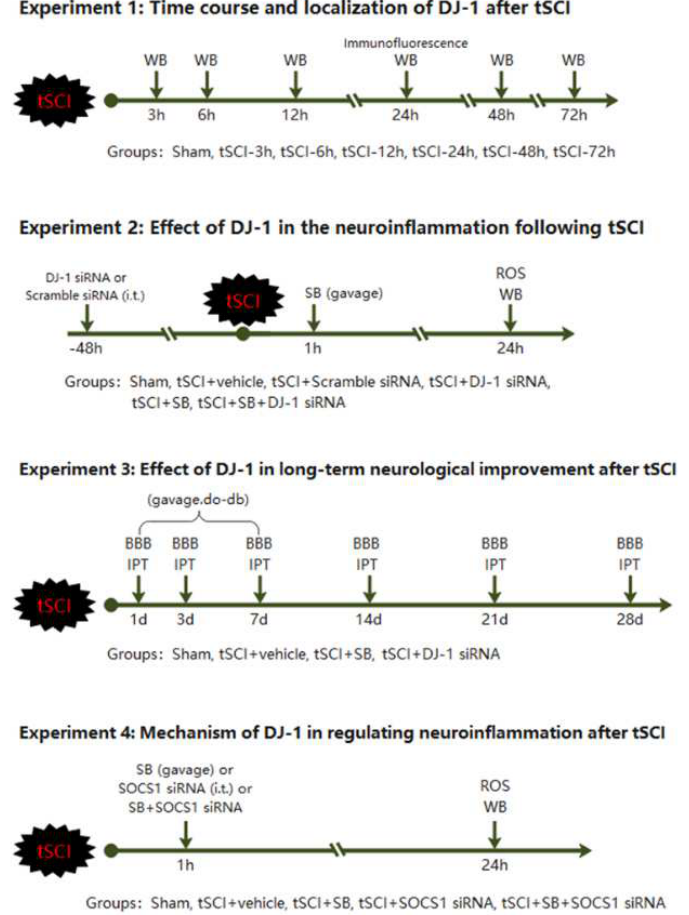
Figure 1. Experimental design and animal groups.